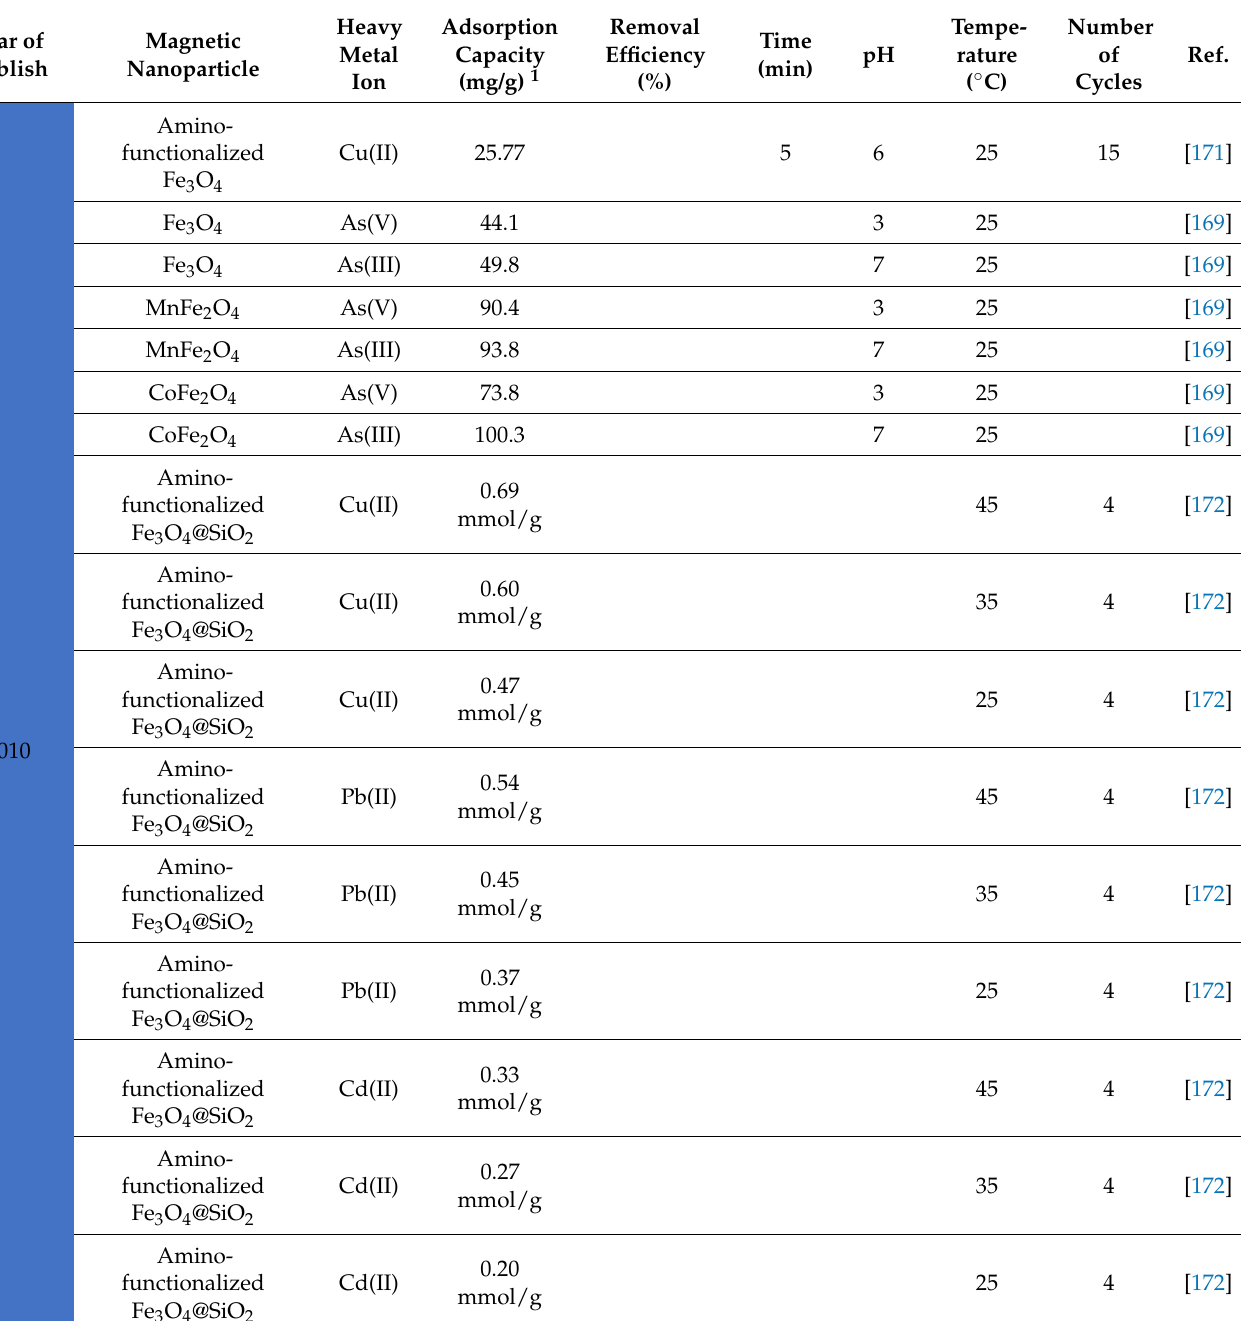
Table 5. Adsorption capacity, removal efficiency, and system